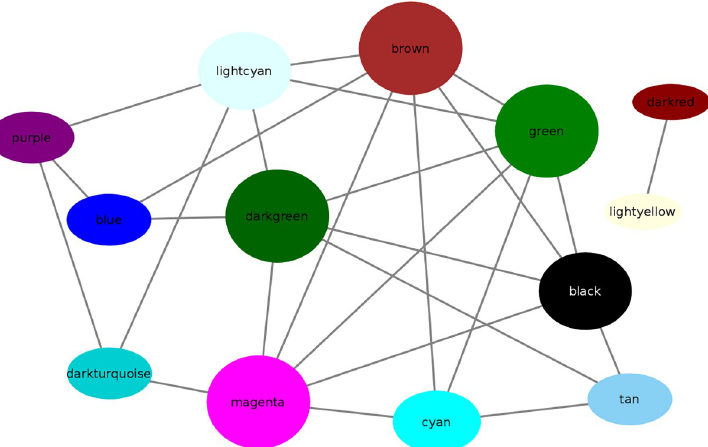
Fig 3. Inter-modular connectivity. Inter-modular connectivity is calculated based on ME. Larger size modules have a high degree (more connections), whereas smaller size modules depict fewer connections with other modules in a network. Modules like darkgreen, brown, green, magenta, black, lightcyan, cyan, tan, blue, purple and darkturquoise showed high degree, whereas smaller modules like darkred as well as light yellow showed a low degree or fewer connections. The edges correspond to ME value between the modules.